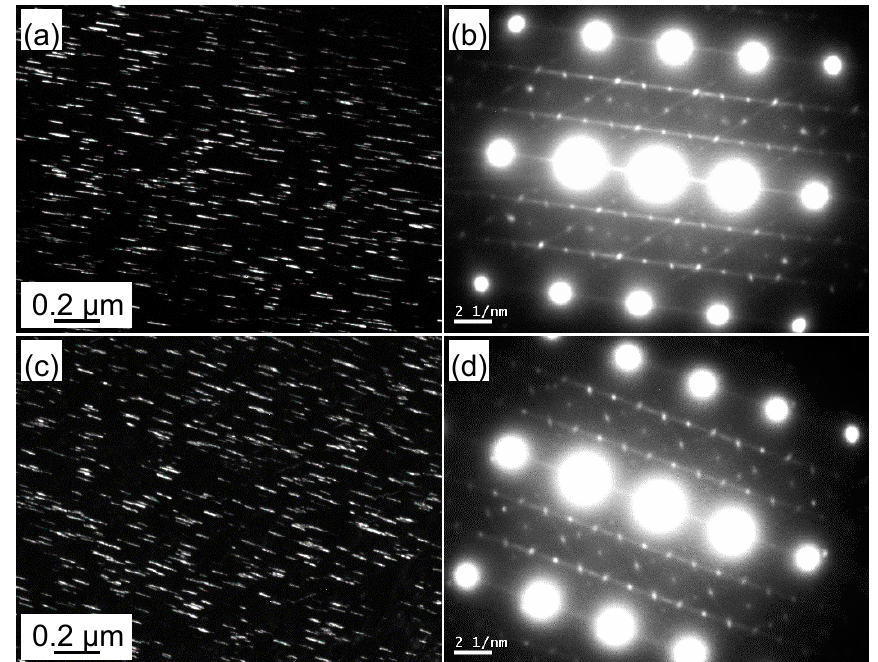
Figure 10. TEM observation showing the dark figure (DF) and the SAED patterns (which subjected the reciprocal changes by the operation of counter clockwise rotation with 90 ◦ to easily correspond the consistent orientation of the studied precipitate located on {111} Al ) of T8-aged samples after annealing at di ff erent temperatures: ( a , b ) 300 ◦ C and ( c , d ) 400 ◦ C.